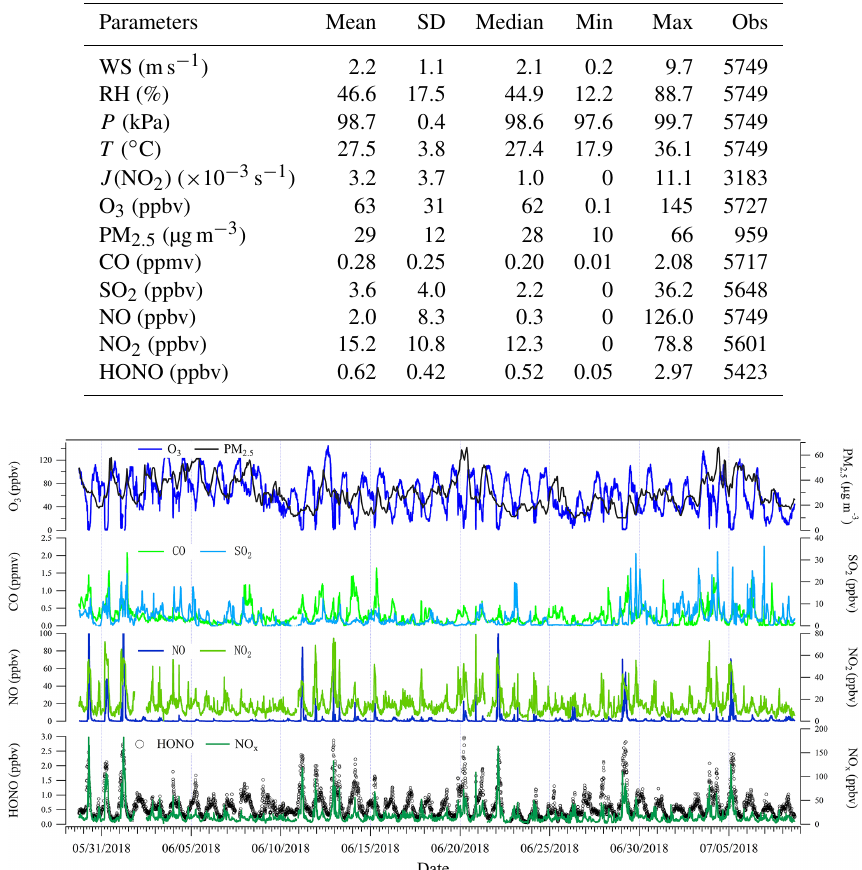
Table 2. Statistic summary of meteorological parameters and the measured species. Note that the observation data point number (Obs) of hourly PM 2 . 5 is about 1 / 6 of others (10min time resolution). The measured rather than the corrected NO 2 was used here. SD: standard deviation. Min: minimum. Max: maximum.